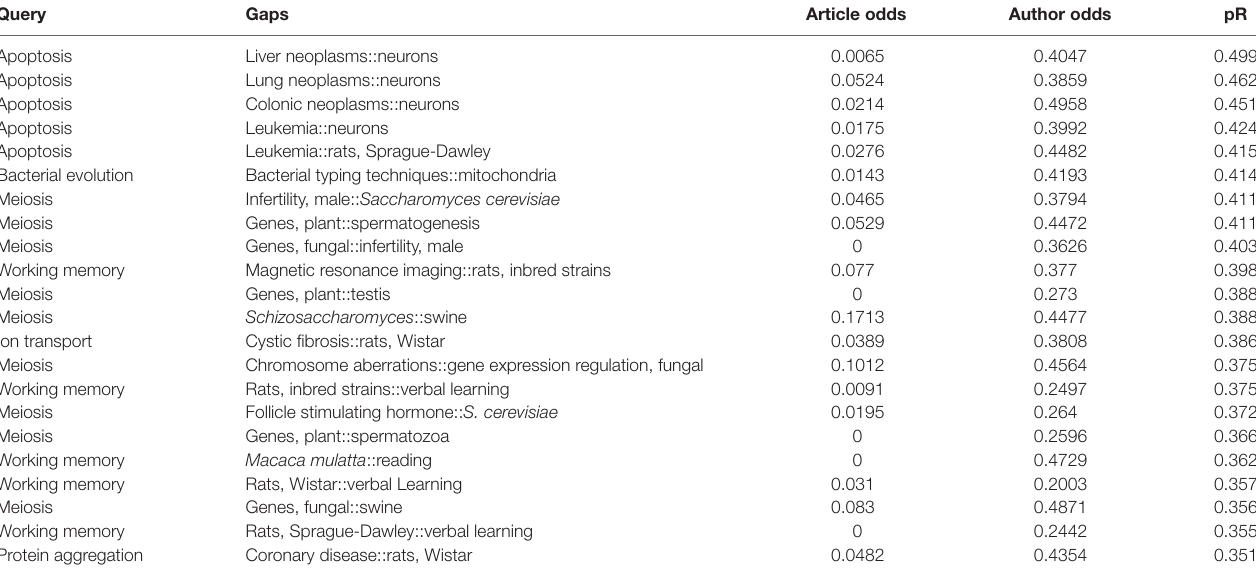
TaBle 4 | gaps across disciplines in biological processes article sets showing some of their relevant features. Query